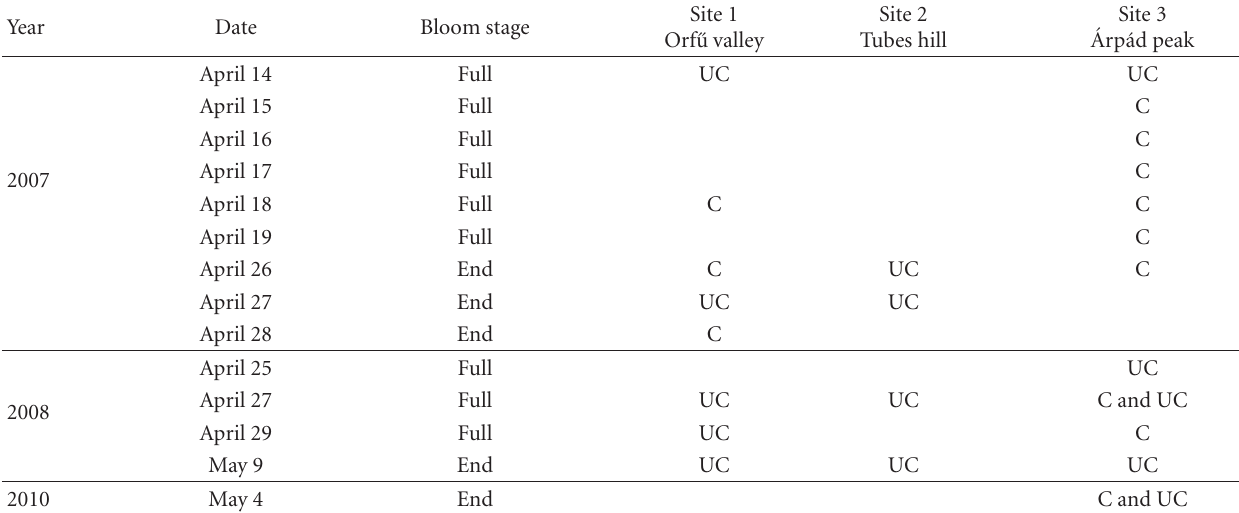
Table 2: Sampling dates and sites, with bloom stage. C: covered flowers; UC: uncovered